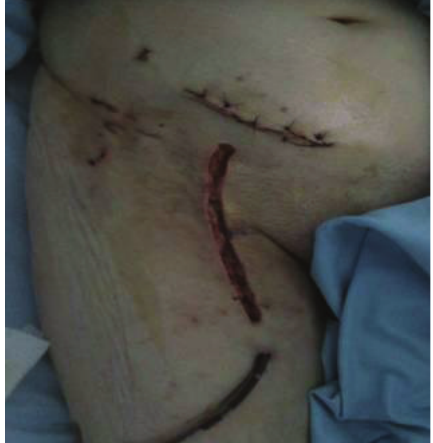
Figure 6: Wounds at the end of surgery.